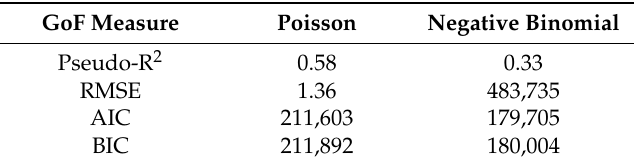
Table 3. Poisson and Negative Binomial model goodness of fit.